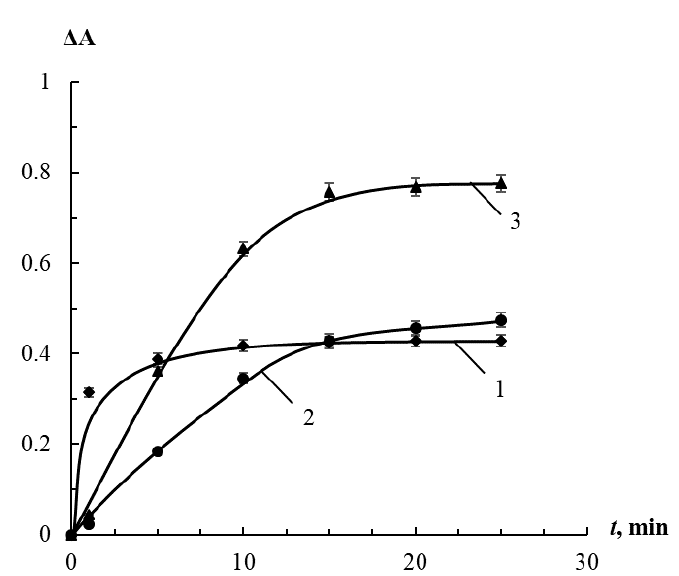
Figure 5. Change in the absorbance of AgTNPs solutions in the presence of hydrogen peroxide (1), tert -butyl hydroperoxide (2) and peracetic acid (3) depending on the interaction time. c (AgTNPs) = 0.16 mM Ag, pH 6. (1) c (HP) = 70 µ M; (2) c (TBHP) = 1200 µ M; (3) c (PAA) = 7.5 µ M.